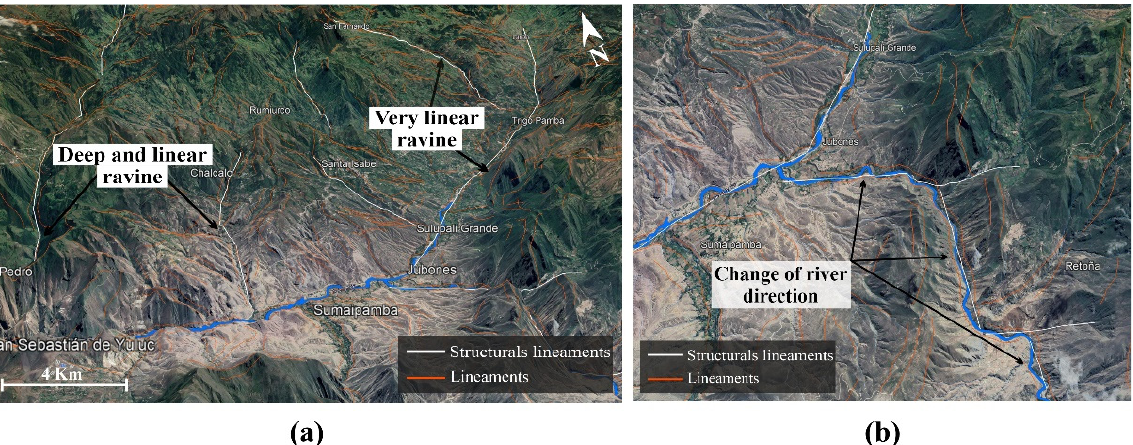
Figure 8 . Analysis of the study area using Google Earth. ( a ) Identification of streams with defined morphostructural features. ( b ) Recognition of changes in the direction of rivers.